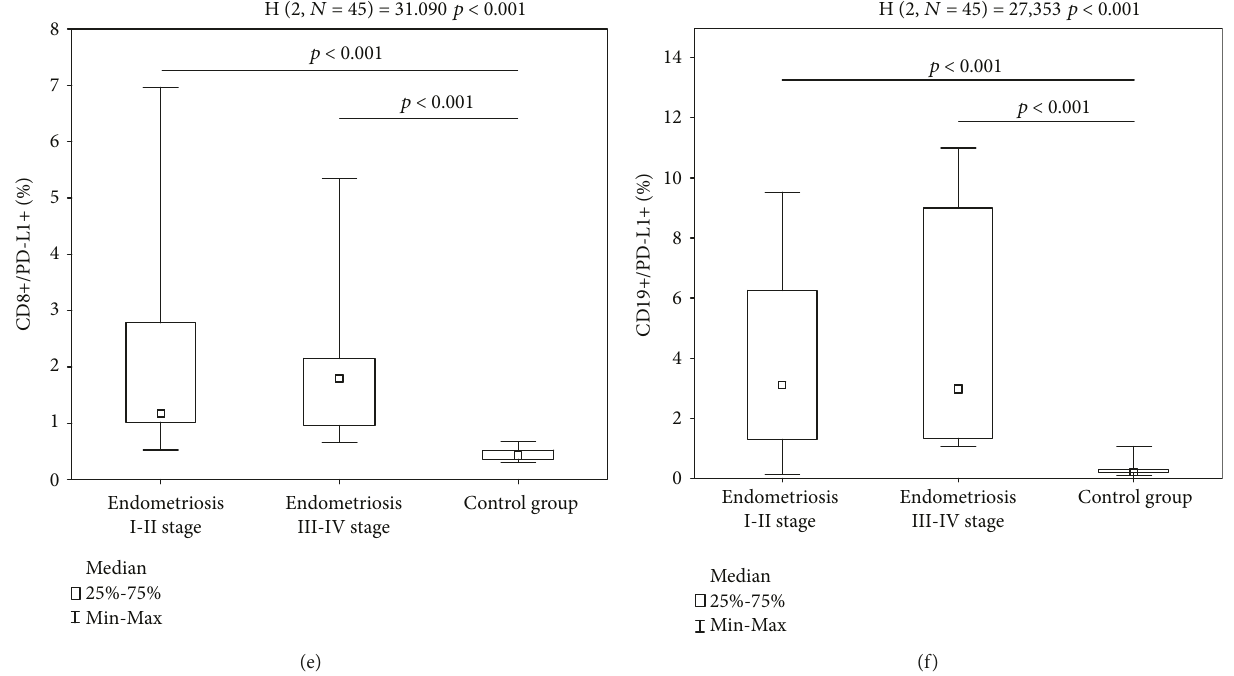
Figure 2: (a) The frequencies of CD4 + /PD-1 + cells in stage I and II endometriosis patients, stage III and IV endometriosis patients, and healthy volunteers. (b) The frequencies of CD8 + /PD-1 + cells in stage I and II endometriosis patients, stage III and IV endometriosis patients, and healthy volunteers. (c) The frequencies of CD19 + /PD-1 + cells in stage I and II endometriosis patients, stage III and IV endometriosis patients, and healthy volunteers. (d) The frequencies of CD4 + /PD-L1 + cells in stage I and II endometriosis patients, stage III and IV endometriosis patients, and healthy volunteers. (e) The frequencies of CD8 + /PD-L1 + cells in stage I and II endometriosis patients, stage III and IV endometriosis patients, and healthy volunteers. (f) The frequencies of CD19 + /PD-L1 + cells in stage I and II endometriosis patients, stage III and IV endometriosis patients, and healthy